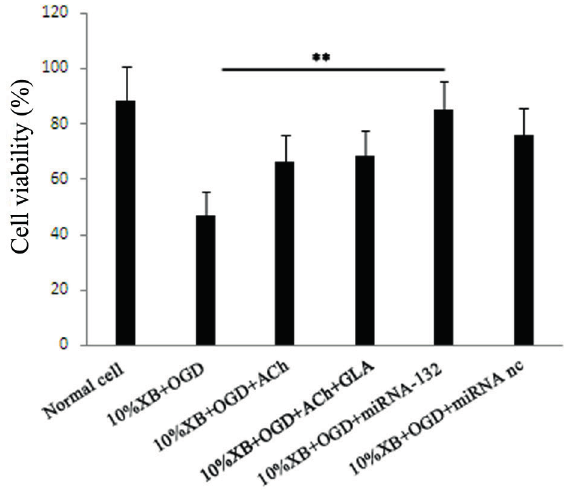
Figure 3: Analysis of cell viability of renal macrophages in rats using the MTT method after processing through different methods. The results are presented as mean ± SD, ** P <